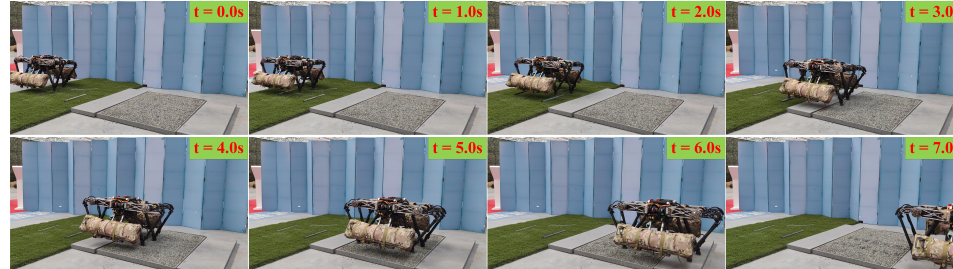
Figure 9. Snapshots of the walking on the grassland and rock terrain